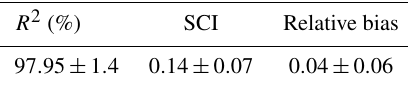
Table 2. Error statistics for the estimated profile from time stacks compared with the measured profiles during